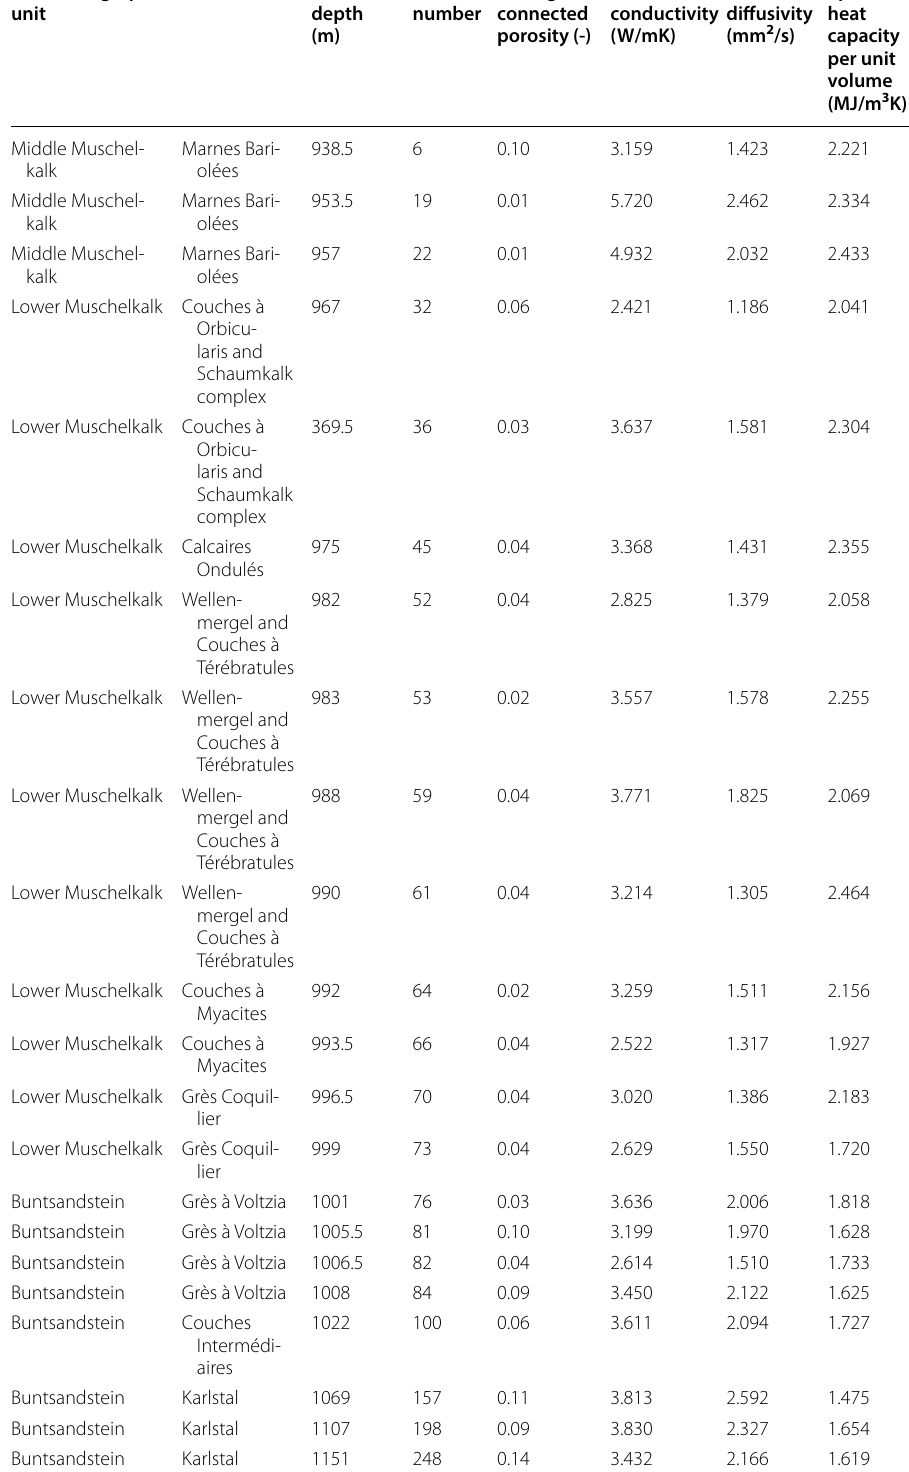
Table 3 Summary of the laboratory thermal property data (thermal conductivity, thermal diffusivity, and specific heat capacity per unit volume) for samples from the Muschelkalk and Buntsandstein sampled from exploration well EPS-1 (Soultz-sous-Forêts) Lithostratigraphic